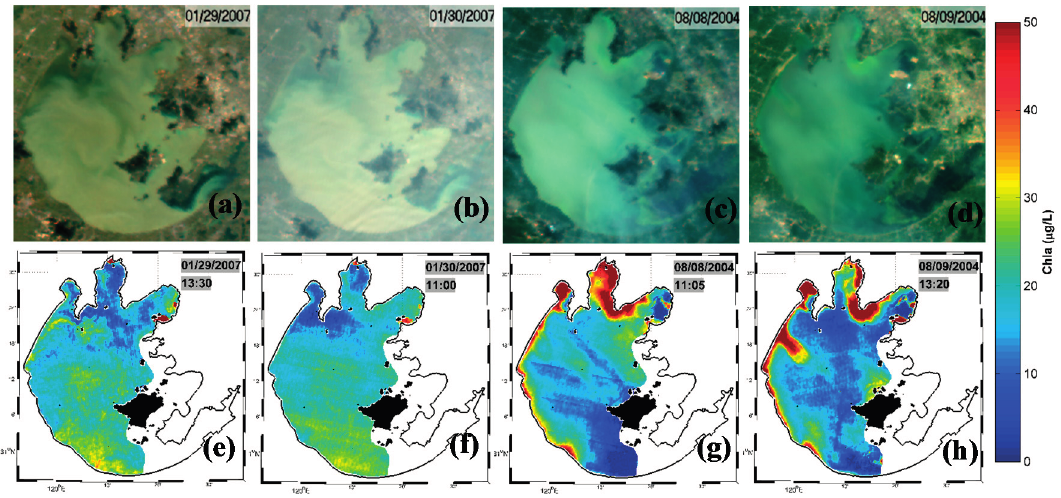
Figure 4. Performance of the Chla retrieval algorithm under different aerosol conditions in both winter (29 and 30 January 2007) and summer (8 and 9 August 2007). The top panels show MODIS RGB images ( a , b , c , d ) while the bottom panels show the retrieved Chla ( e , f , g , h ).The RGB images in winter (a,b) show significant variations in the aerosol content (haziness); yet the retrieved Chla images (e,f) are consistent in the large-scale spatial patterns and Chla magnitudes (e.g., higher Chla in the southern lake than in the northern lake); Likewise, for the bloom cases in summer, the retrieved Chla patterns in (g,h) appear to be insensitive to different aerosol perturbations in (c,d). Note that the optically shallow waters in the eastern lake are masked to prevent algorithm